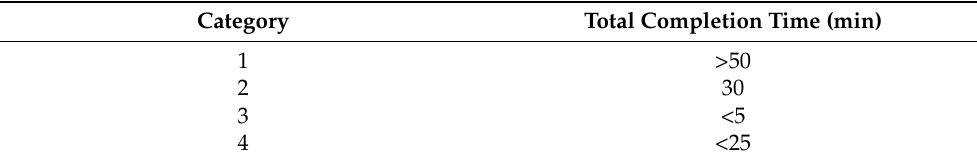
Table 4. Total completion time per category for the left lane.